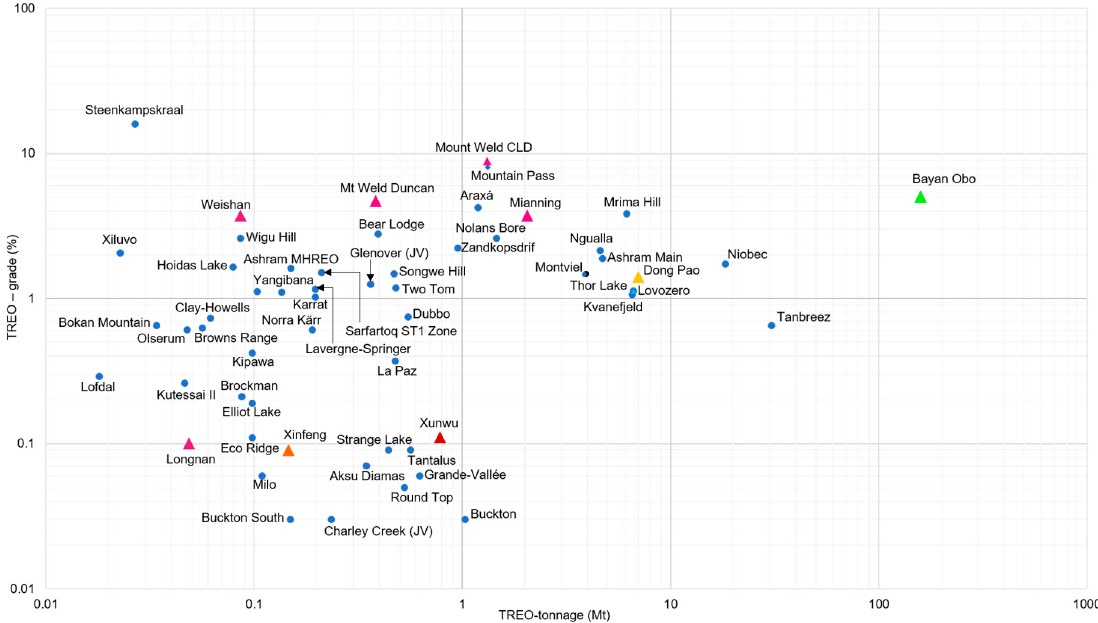
Figure 7. The ore grade and tonnage for advanced stage REE deposits.